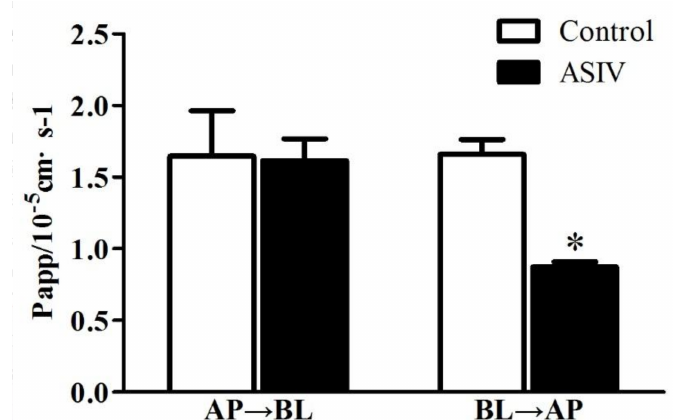
Figure 3. Effect of tariquidar on the transportation of ASIV across bEnd.3 cells. Values are expressed as mean ± S.D. ( n = 3). Data were analyzed by unpaired t -test. * p < 0.05 vs. control group. AP → BL: permeability of ASIV from apical side to basal side. BL → AP: apparent permeability of ASIV from basal side to apical